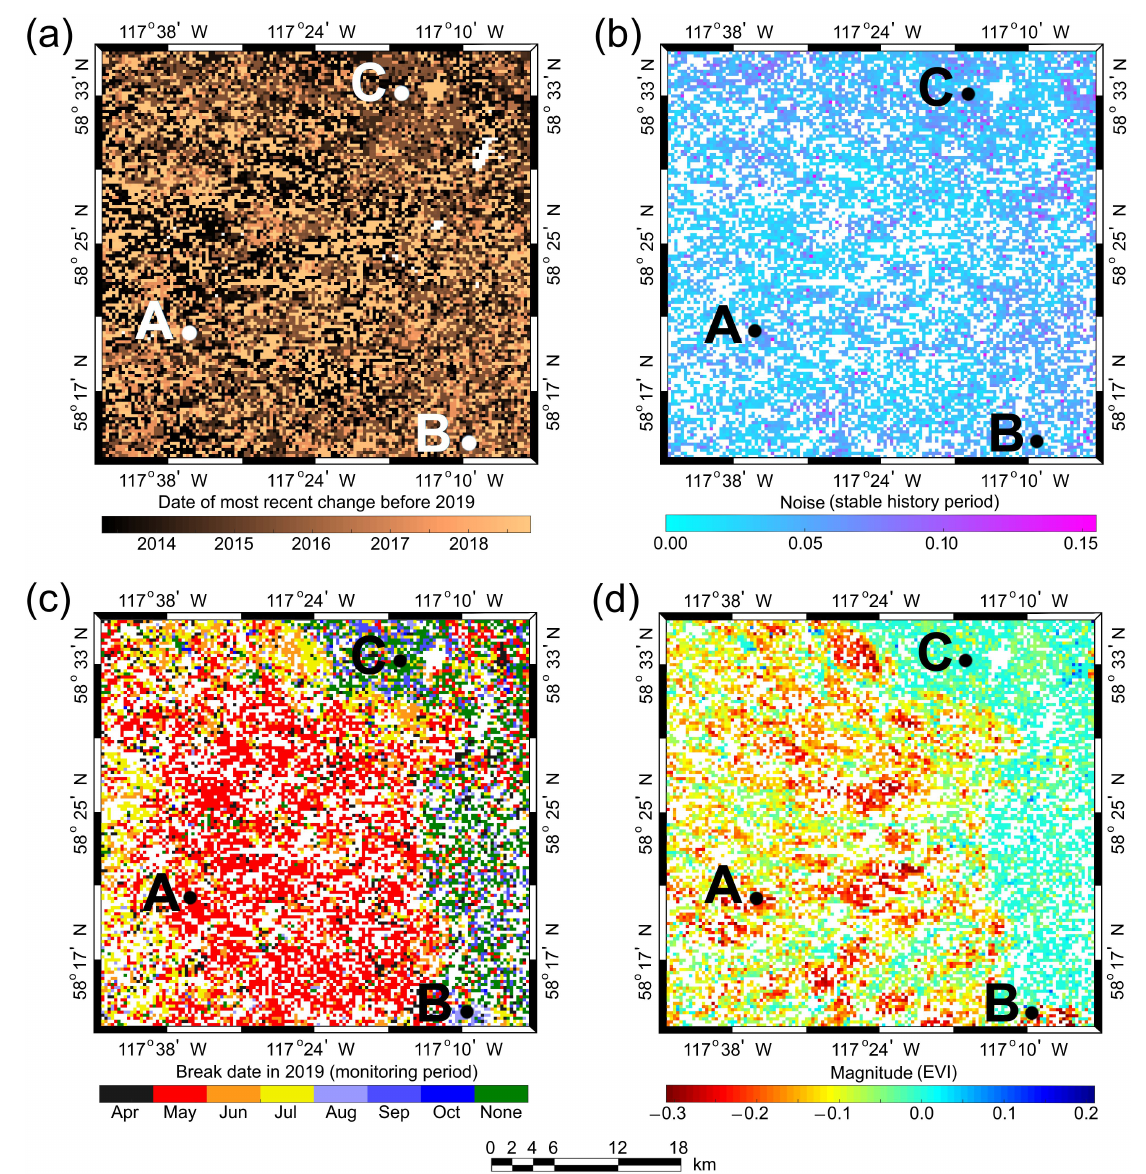
Figure 7. Statistical results for the study region obtained from analyzing per-pixel EVI time series, where each pixel has a resolution of 300 m. ( a ) the estimated date map of the most recent disturbances before 2019 for visualizing SHP, ( b ) spatial variation of the noise level for SHP (i.e., the standard deviation of the residual series in SHP), ( c ) the estimated dates of detected disturbances in MP (April–November, 2019), and ( d ) the change magnitude. Please note that the panels only show the results for the areas where the weighted average EVI shown in Figure 2 is greater than 0.2. Also, panels ( b – d ) are obtained only for the areas with at least two years SHP, i.e., for the areas whose most recent disturbance dates, shown in panel ( a ), are before 2017. The detailed analyses of pixels A, B, and C are demonstrated in Figure